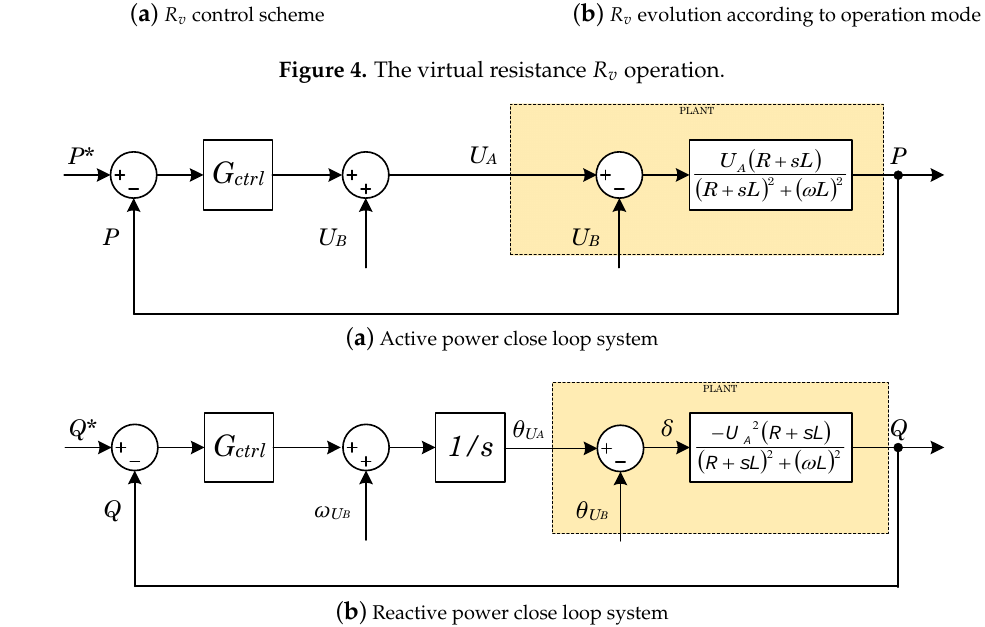
Figure 5. Resistive case power close loop scheme under dynamic